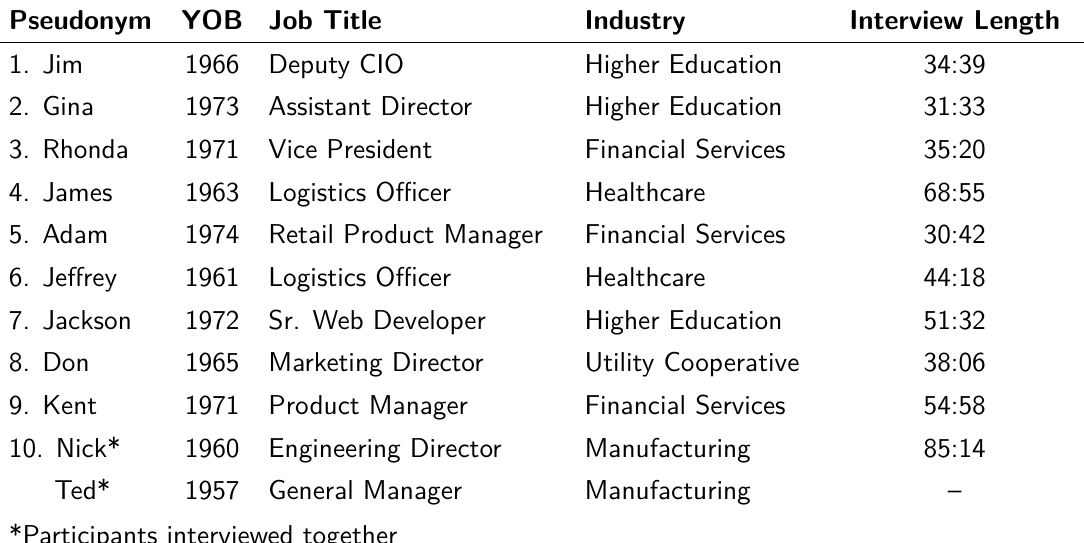
Table 1. Key Informant